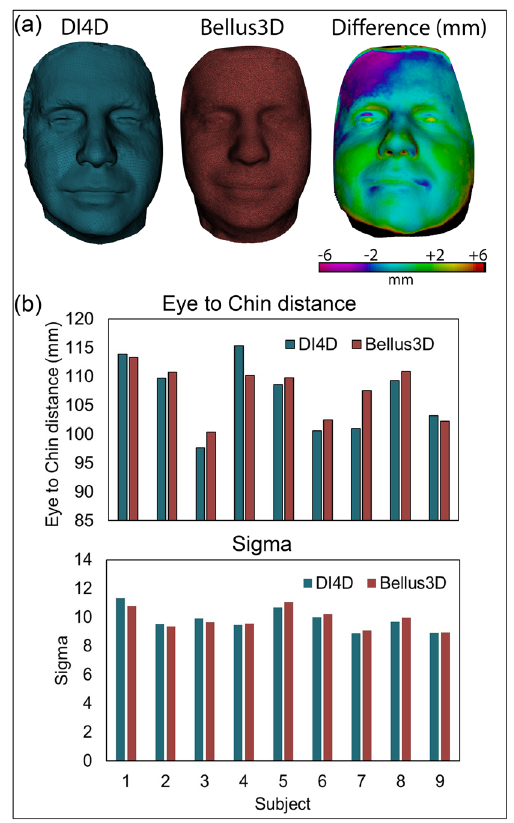
Figure 4. Comparison of DI4D and Bellus3D scanning method showing ( a ) typical false colour direct comparison highlighting deviation between the two techniques for a subject and ( b ) the extracted measurements of eye-to-chin distance and ‘σ’ from two different scanning methods of nine